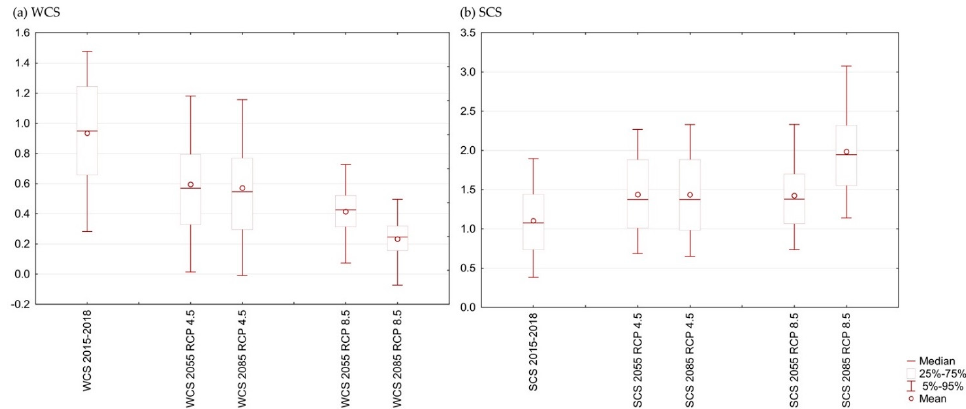
Figure 5. Boxplots of values of the WCS ( a ) and SCS ( b ) indexes in 7967 localities in mainland Spain for the period 2015–2018 and future periods. Appl. Sci. 2021 , 11 , x FOR PEER REVIEW Table 3. Dynamics of changes in climate zones according to scenarios.